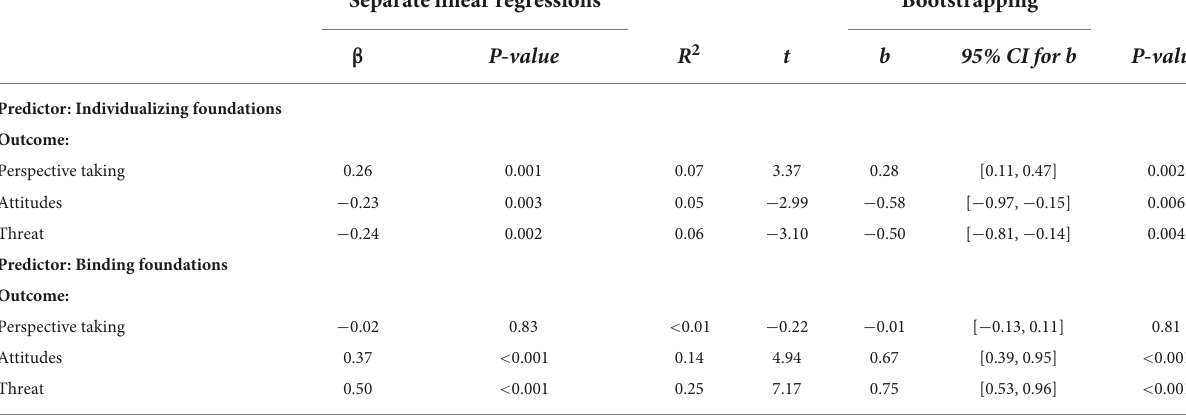
TABLE 1 Linear regression analyses of moral foundation indexes to outcomes for Study 1.